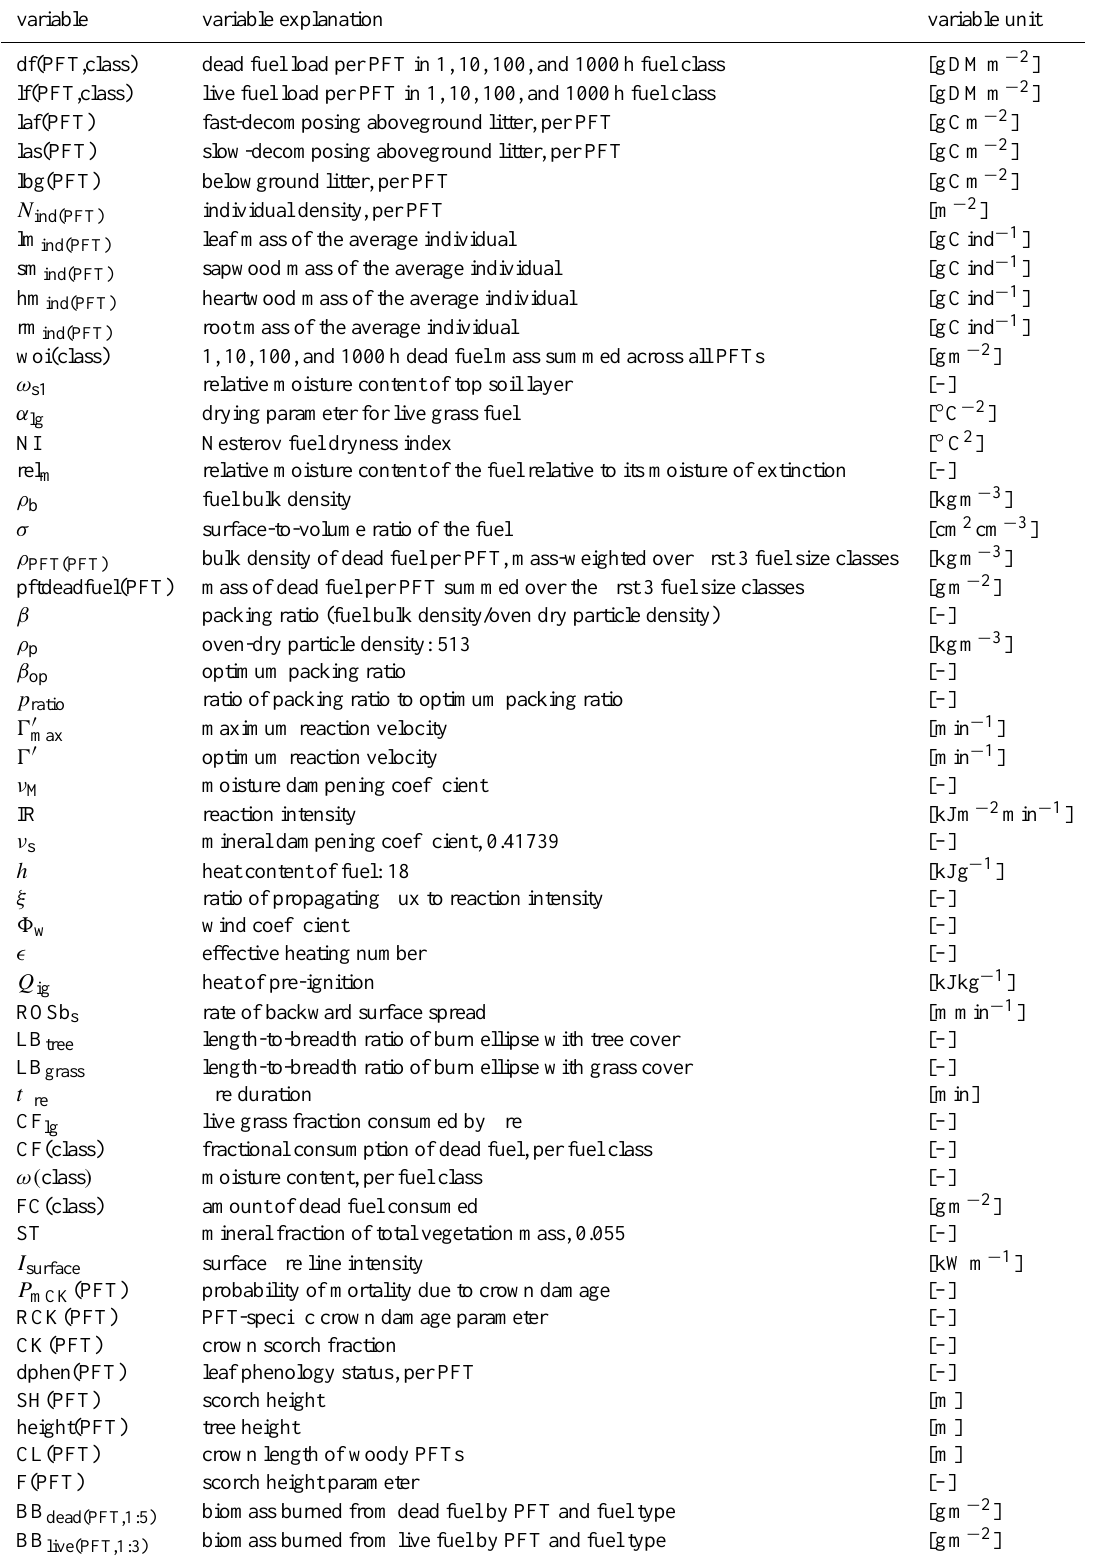
Table A2. Explanation of variable and parameter abbreviations.